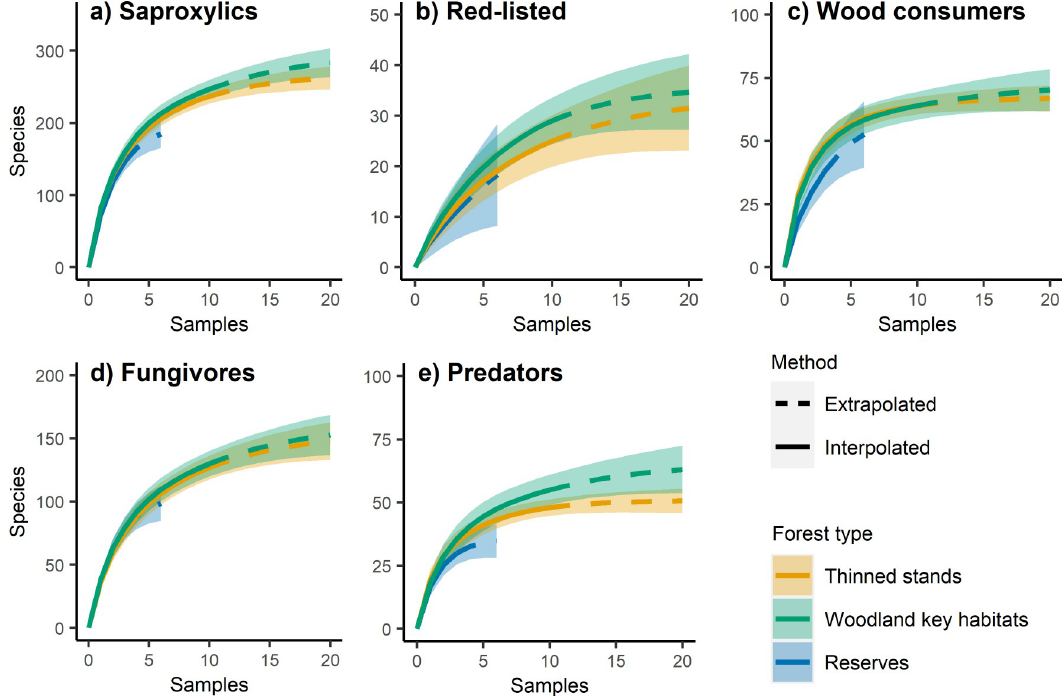
Fig 5. Gamma diversity Jo¨nko¨ping. a-e) Species accumulation curves with 95% confidence intervals for each forest type and species group from the Jo¨nko¨ping sample. Samples are forest stands (data from two traps per stand pooled), extrapolated to twice the original sample